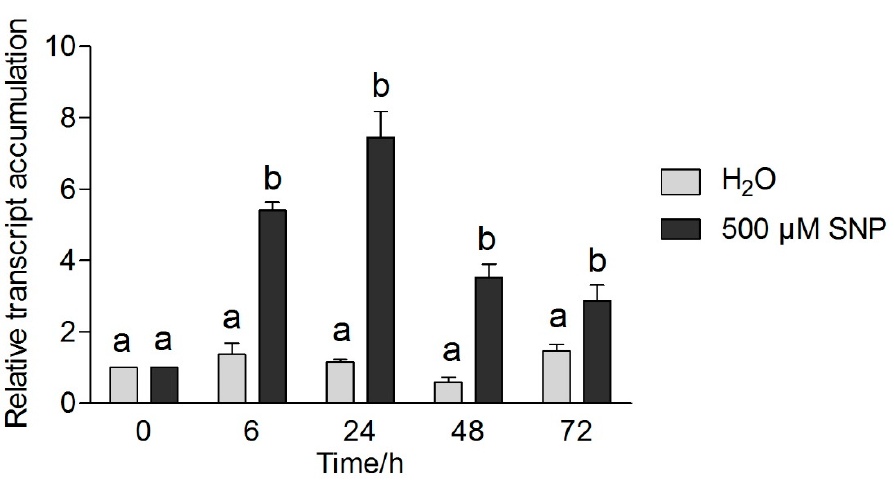
Figure 8. Expression of the CsICE1 genes under cold stress.